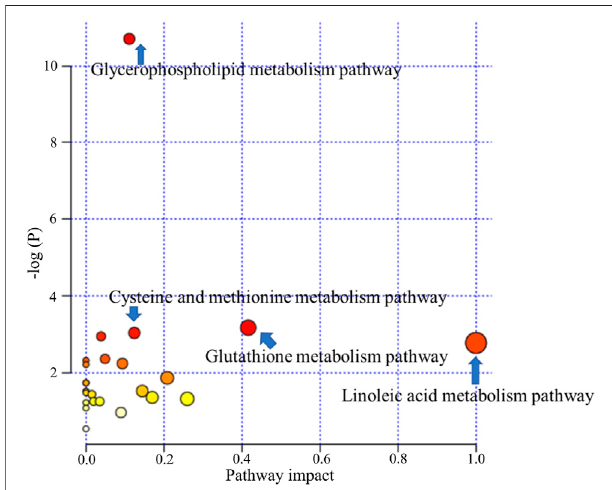
FIGURE 10 | Metabolism pathways related to liver injury and LCS